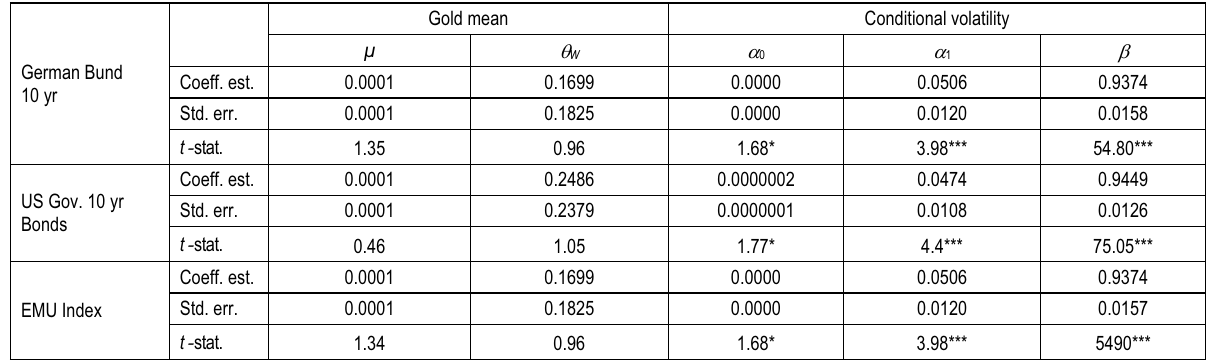
Table 8. Estimation results for Government Bonds – reverse causality test